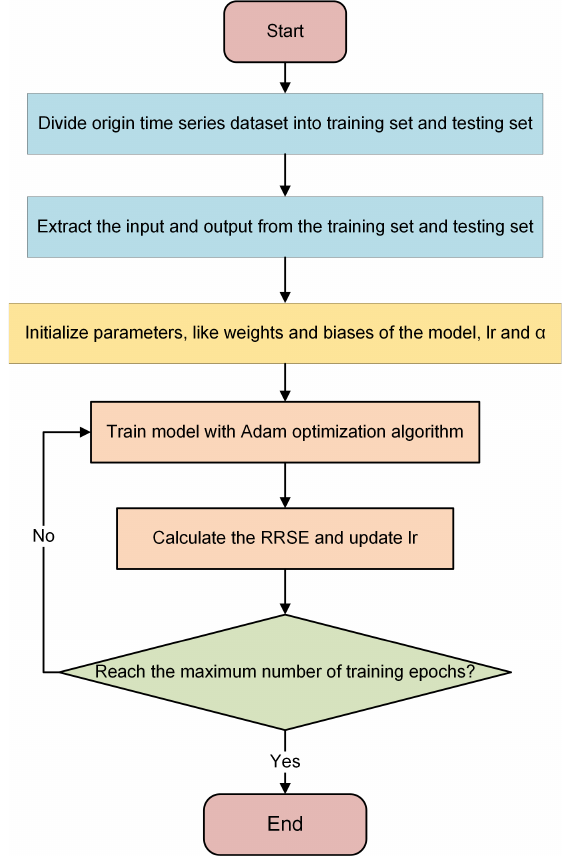
Figure 5. The flowchart presenting the training